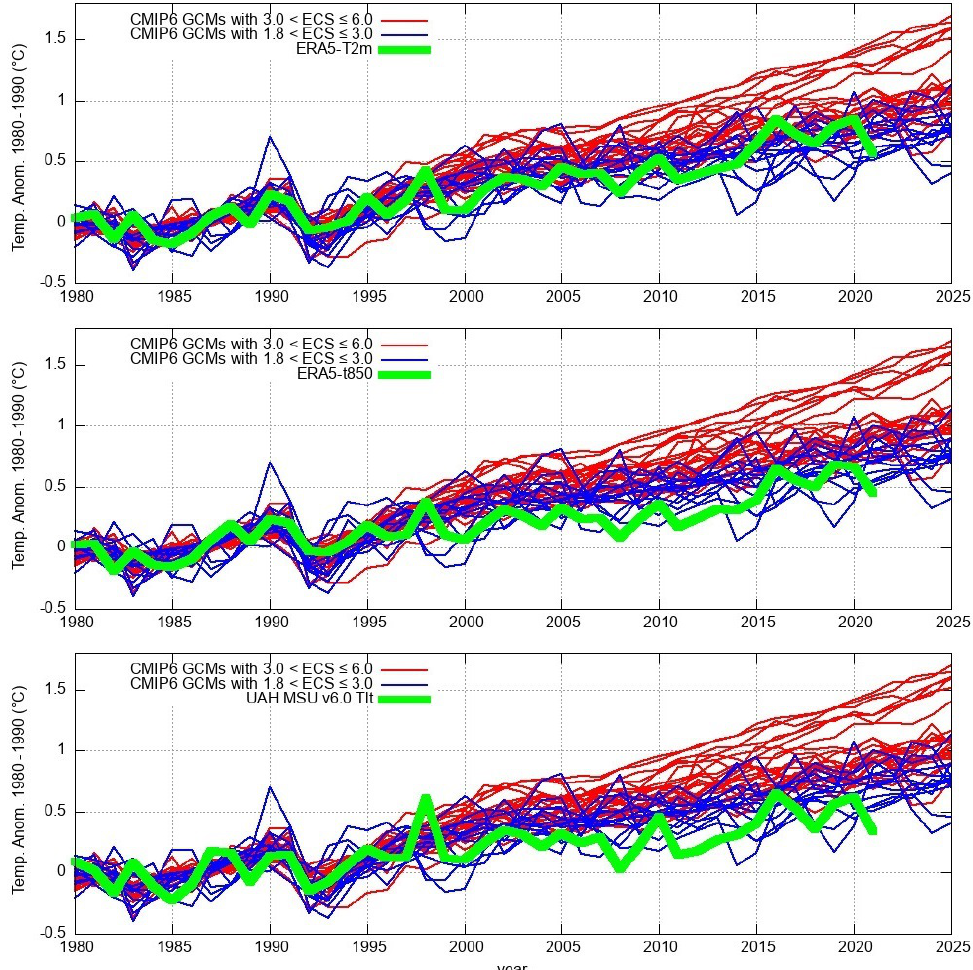
Figure 2. CMIP6 GCM surface temperature simulations (red, models with ECS > 3; blue, models with ECS ≤ 3) against the temperature observations (green): ERA5-T2m, ERA5-850mb, and UAH MSU v.6.0